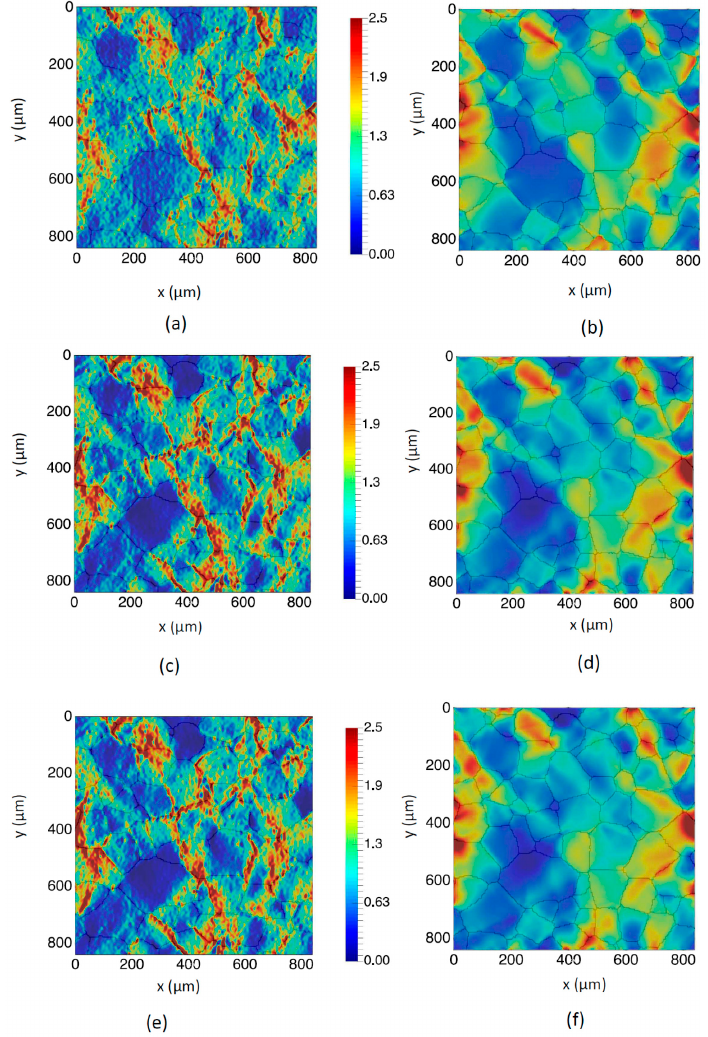
Figure 25. The strain maps obtained by the SEM-DIC experiment compared to the CPFE prediction in WE-43 T6 sample during uniaxial tension at different strain values: ( a ) ε = 0.76% (SEM-DIC), ( b ) ε = 0.76% (Simulation), ( c ) ε = 4.83% (SEM-DIC), ( d ) ε = 4.83% (Simulation), ( e ) ε = 8.15% (SEM-DIC), ( f ) ε = 8.15% (Simulation) (After Ganesan et al.